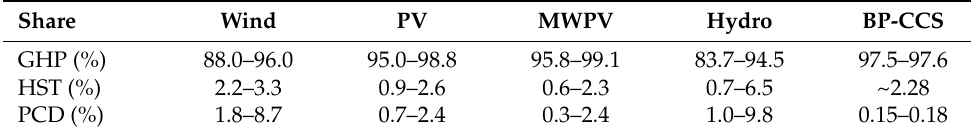
Table 4. Contributions of three stages to life cycle of GHG emissions.